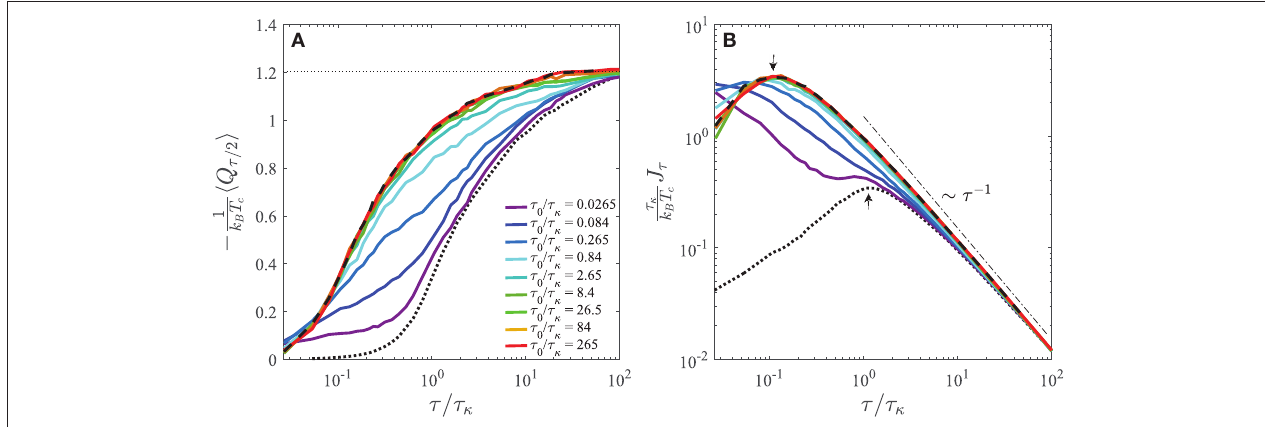
Q τ/ 2 , as a function of the cycle time τ , −h i